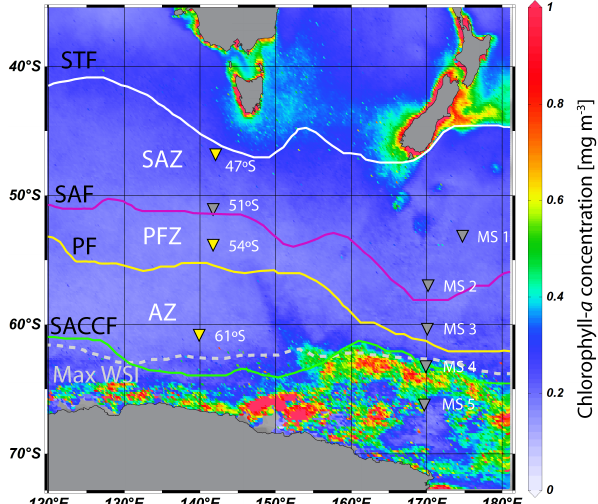
Figure 1. Southern Ocean chlorophyll a composite map (Septem- ber 1997 to September 2007) from Sea-viewing Wide Field-of-View Sensor (SeaWiFS) with the location of the sediment trap moorings of the SAZ (47, 51, 54 and 61 ◦ S) and AESOPS (MS-1, MS-2, MS-3, MS-4 and MS-5) experiments. Abbreviations: STF – sub- tropical front, SAZ – Subantarctic Zone, SAF – Subantarctic Front, PFZ – Polar Frontal Zone, PF – polar front, AZ – Antarctic zone, SACC – Southern extent of the Antarctic Circumpolar Current, Max WSI – maximum winter sea ice extent. Oceanic fronts from Orsi et al. (1995). Sea ice extent from Fetterer et al. (2002, updated